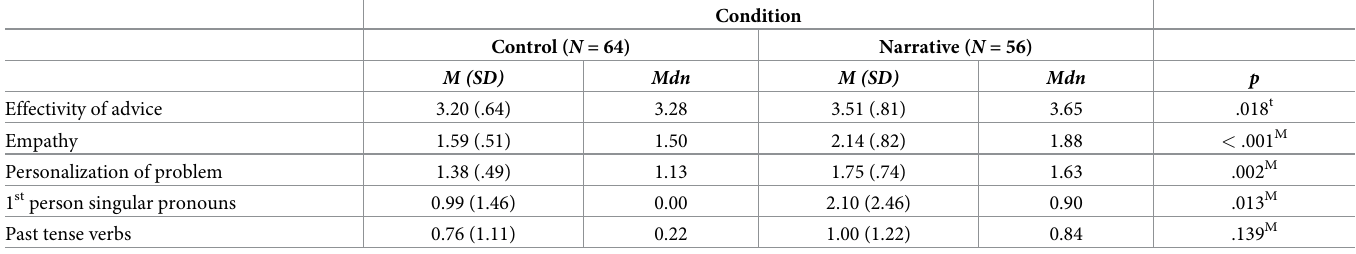
Table 9. Comparison of control vs. narrative mindset conditions on the effectivity of advice, empathy, personalization of problem, and the LIWC measures (the emotional problem-solving